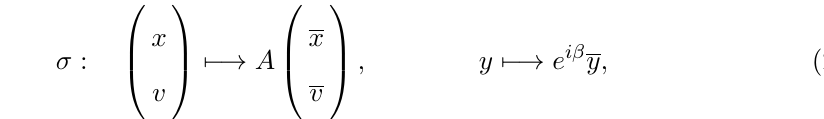
(cid:12)xed points 2 and 4 on the hexagonal lattice and leaves the other two points 1 and 3